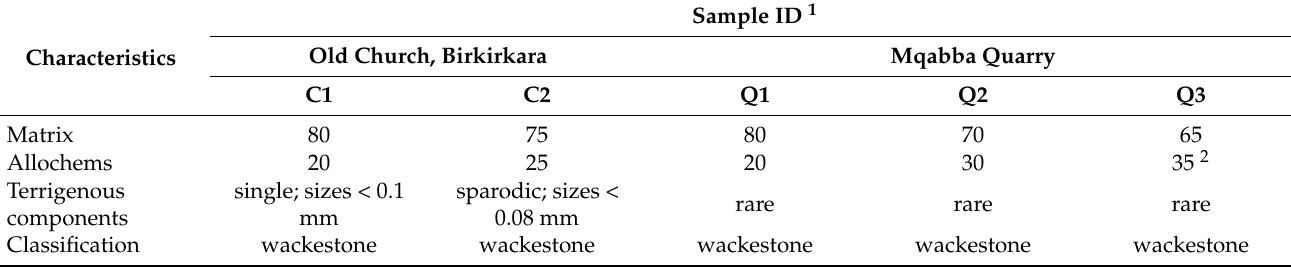
Table 5. Petrographical characteristics